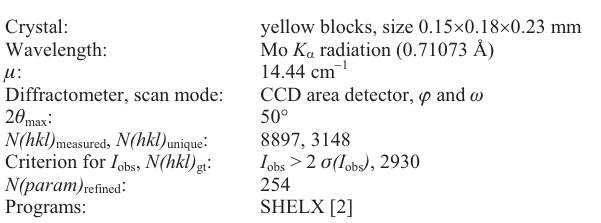
Table 1. Data collection and handling.